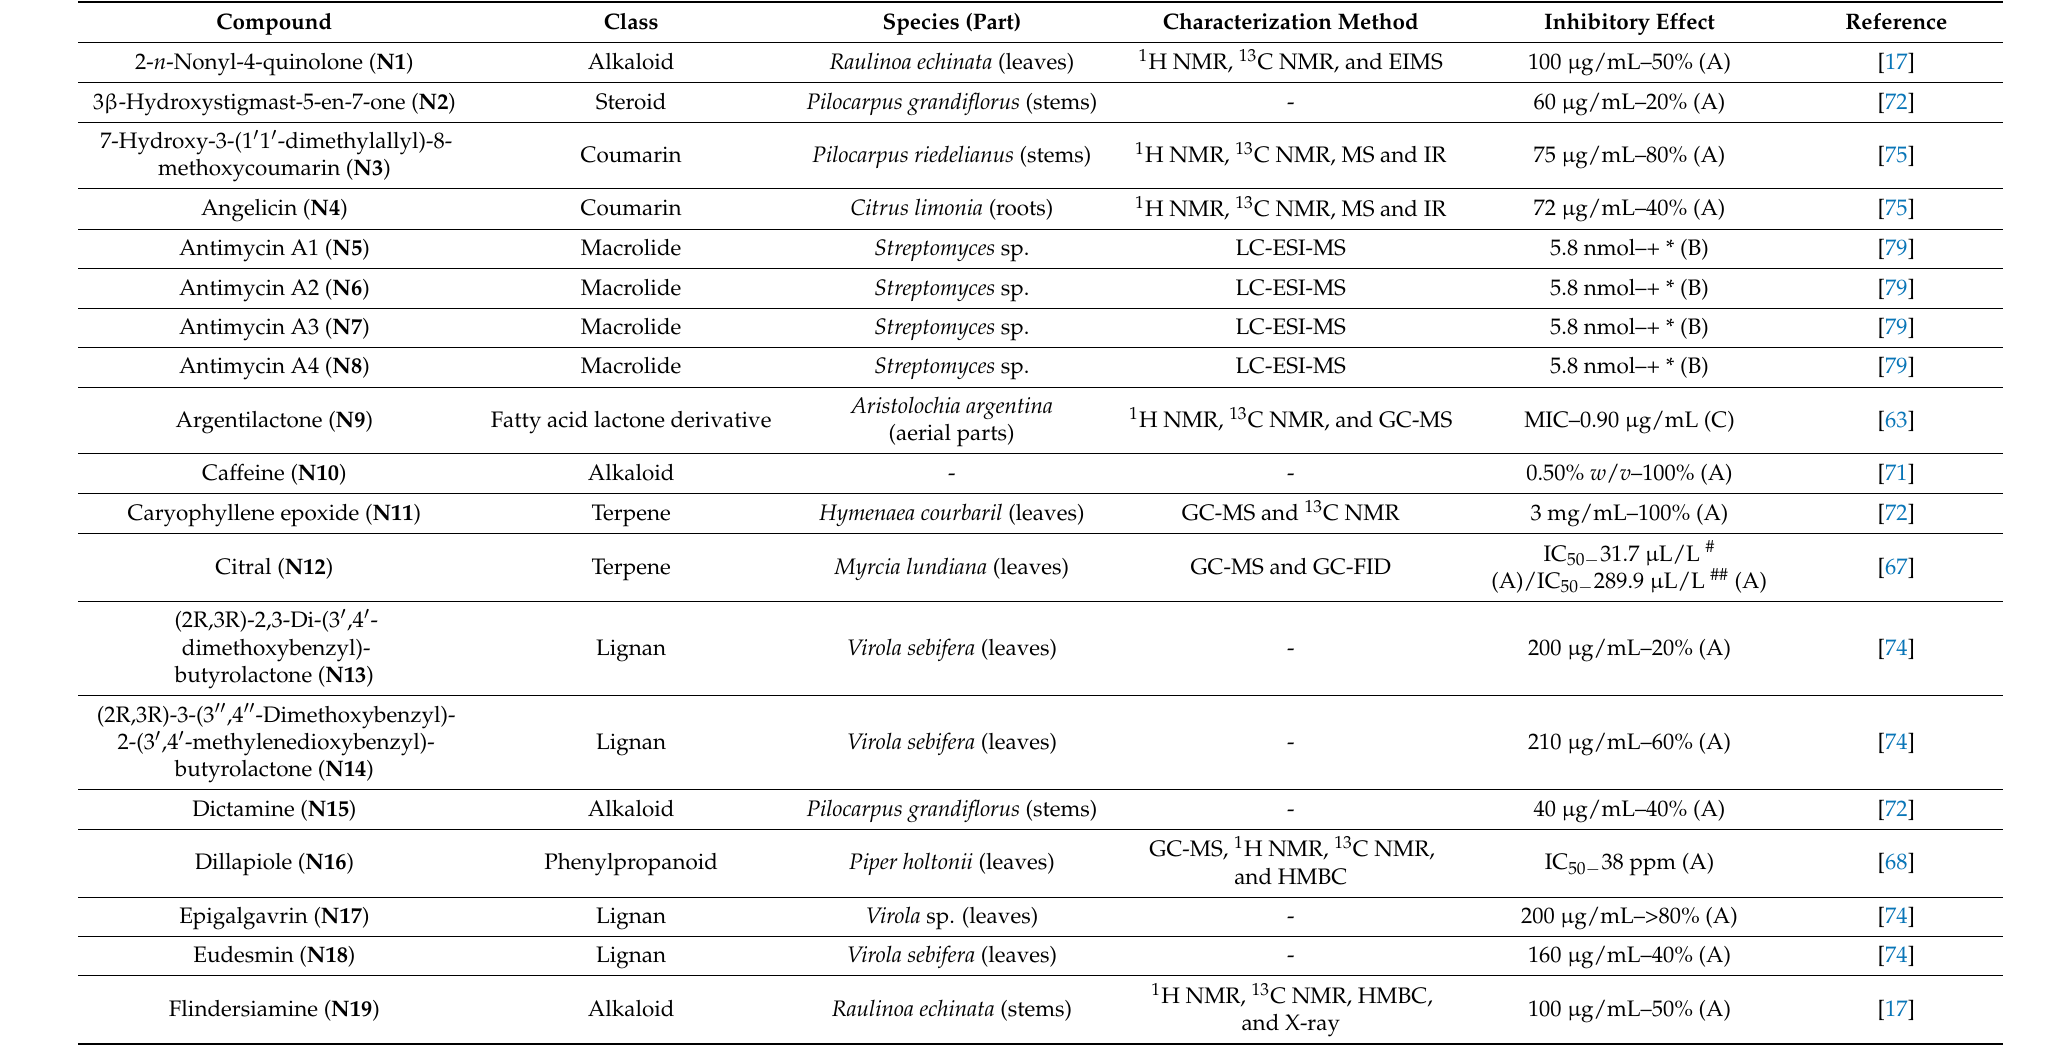
Table 3. Isolated compounds with potential antifungal effects against Leucoagaricus gongylophorus by in vitro